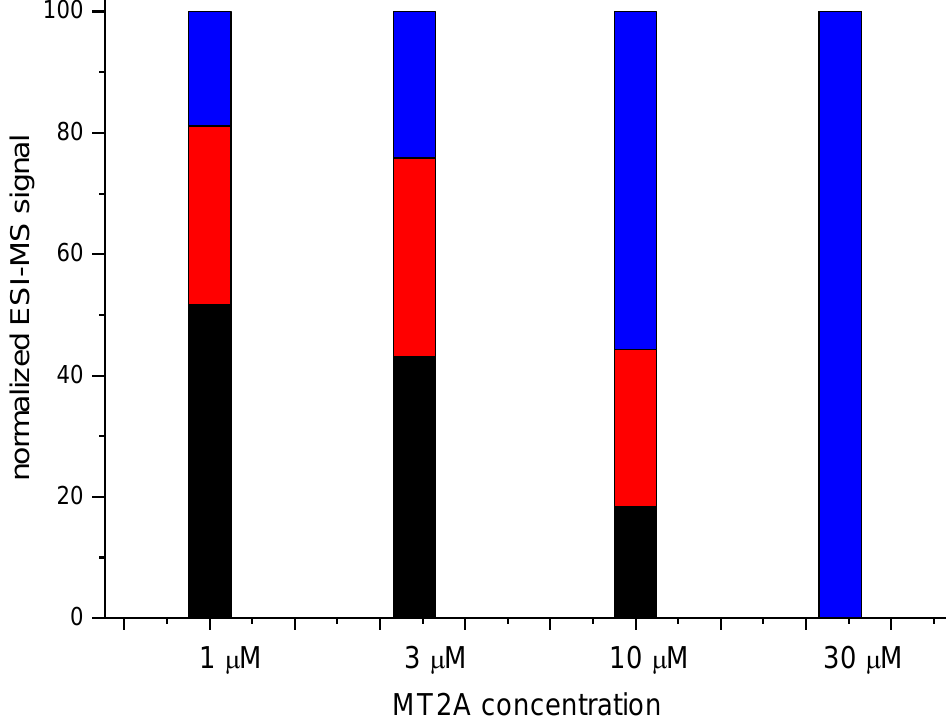
Figure 8. Quantitation obtained by careful integration of relevant signals from native MS experiment of 10 µ M 5R-hepcidin and 20 µ M Cd(II) acetate titrated with Zn 7 MT2A in ammonium acetate, pH 7.4. 5R-hepcidin (blue), Cd5R-hepcidin (red), Cd 2 5R-hepcidin (black).